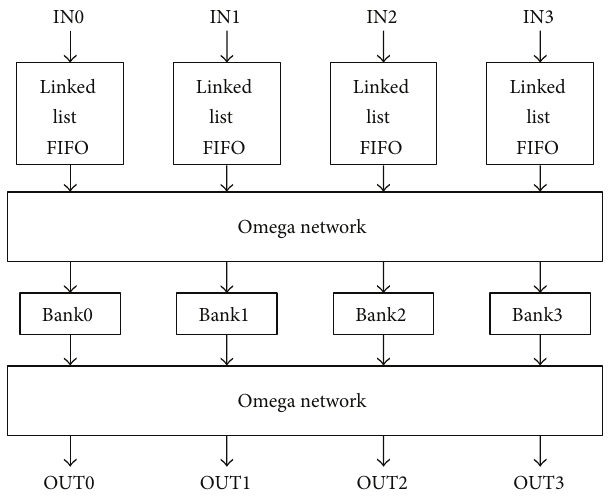
Figure 8: In the Omega multiport memory all the buffering occurs inthelinkedlistFIFOs.Theuseofmultistageinterconnectnetworks, in this case Omega networks, helps reduce the area of the